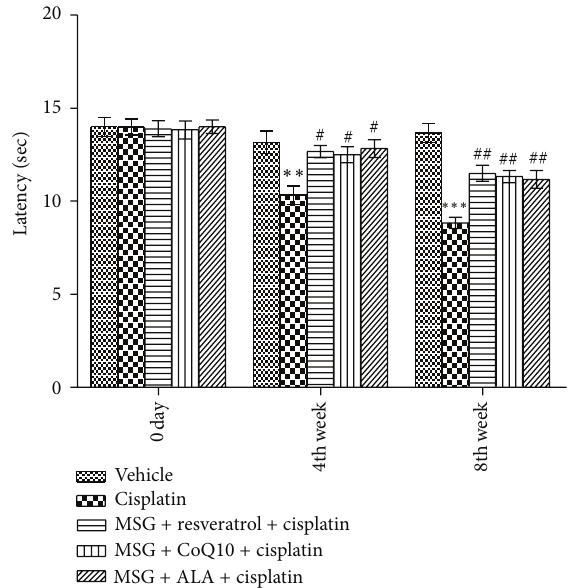
Figure 3: Effect of chronic treatment with combination of MSG and resveratrol/ALA/CoQ10onthermalhyperalgesiaincisplatintreated rats. ∗∗ ( 𝑃 < 0.001 ), ∗∗∗ ( 𝑃 < 0.001 ) versus control group, # ( 𝑃 < 0.05 ), ## ( 𝑃 < 0.01 ) versus cisplatin treated